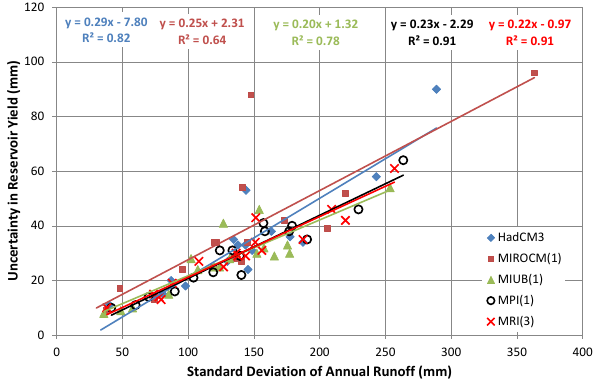
Figure 14. Within-GCM uncertainty (mmyr − 1 ) in reservoir yield versus standard deviation of annual runoff based on 100 Gould– Dincer Gamma estimates (hypothetical capacity: τ = 3, reliability of draft: 95%) from PERM runs of monthly precipitation and tem- perature replicates (2015–2044, A1B) from five